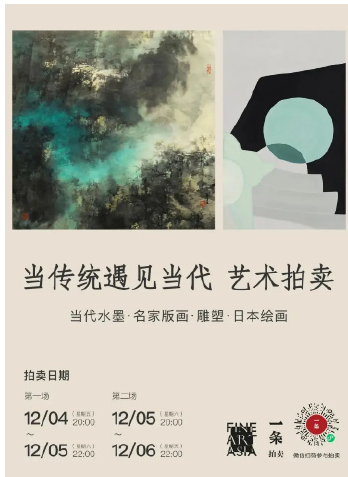
Figure 4. Poster of online art auction. When Tradition Meets Contemporary Art (contemporary ink art, famous prints, sculpture, and Japanese paintings). December 2021. Courtesy: YIT Art and Fine Art Asia. The online auction event, held by the Shanghai-based YIT Art and Hong Kong-based Fine Art Asia features sales of contemporary ink art, famous prints, sculpture, and Japanese paintings.